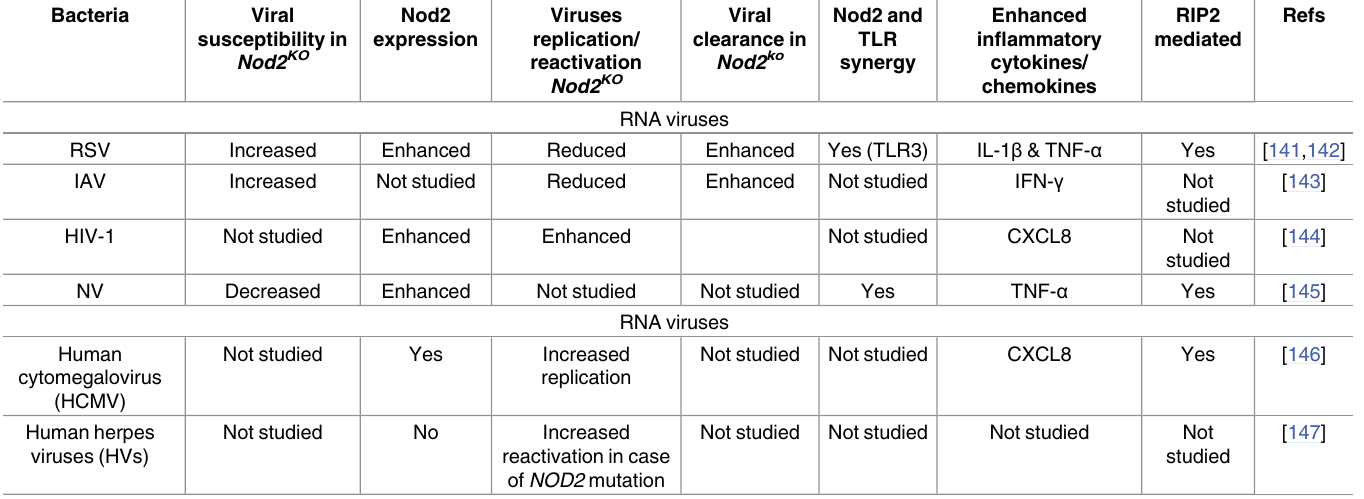
Table 2. Role of Nod2 in the host response toward viruses.